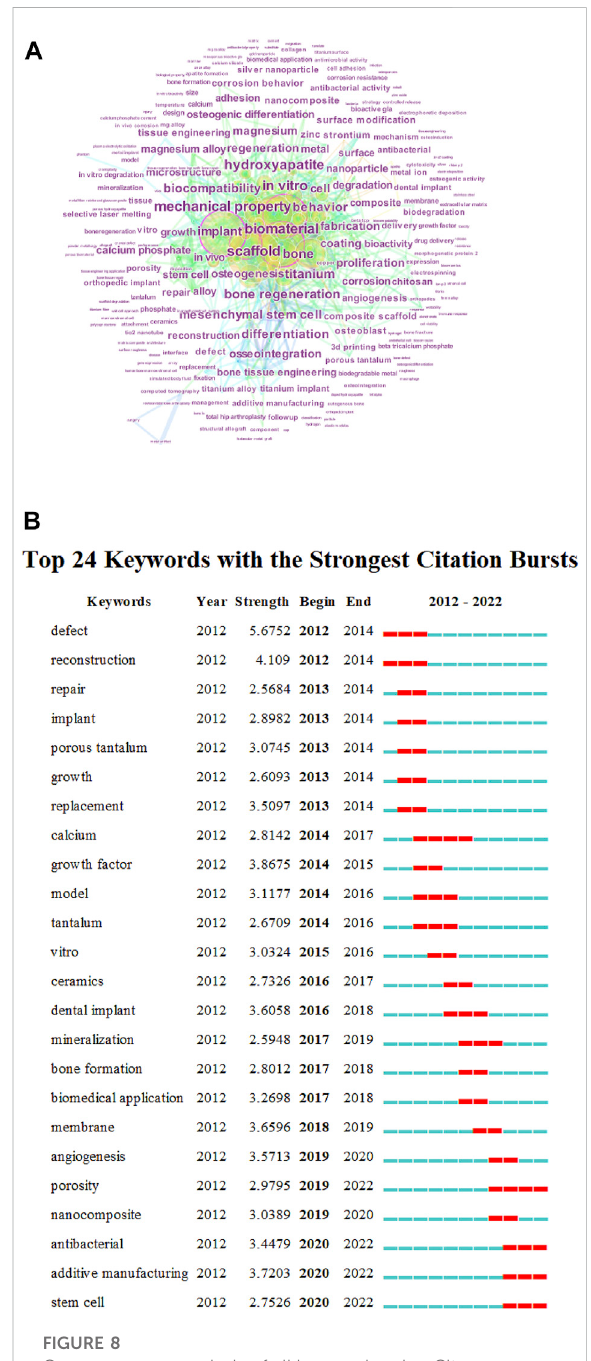
FIGURE 8 Co-occurrence analysis of all keywords using Citespace in the publications on metal materials and bone repair. (A) Mapping of the keywords in the fi eld of metal materials and bone repair. The size of the circle represents the frequency of keywords. (B) Top 24 keywords cited most frequently from 2012 to 2022, which have received continuous attention for a period of time. The red bars represent frequently cited keywords during this time period, and the green bars represent infrequently cited keywords.